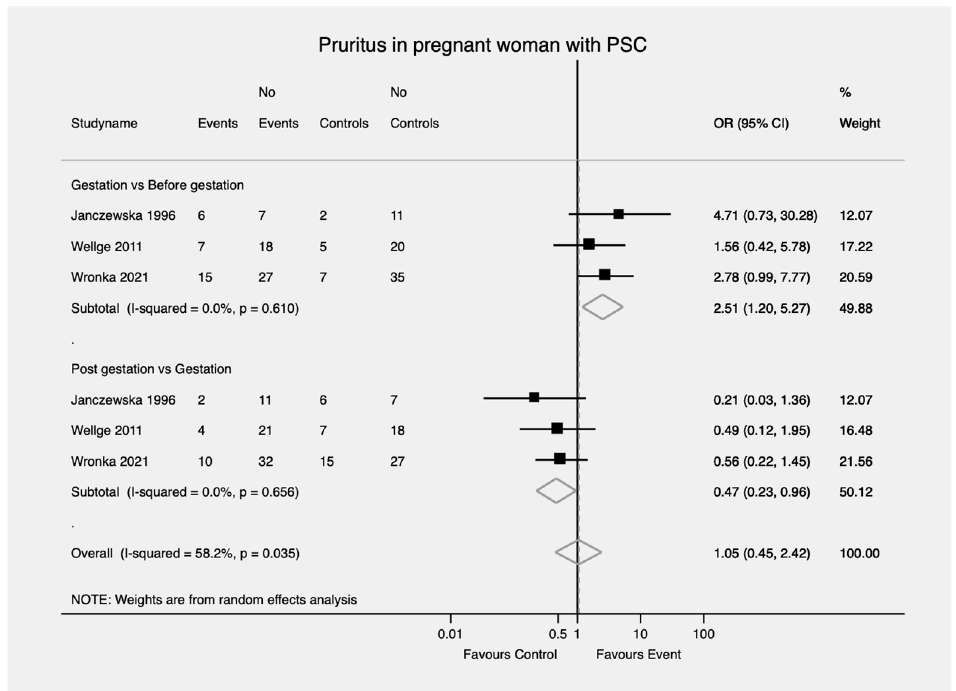
Figure 5. Pruritus in pregnant woman with PSC. PSC—Primary sclerosing cholangitis; OR—Odds ratio; CI—Confidence interval.